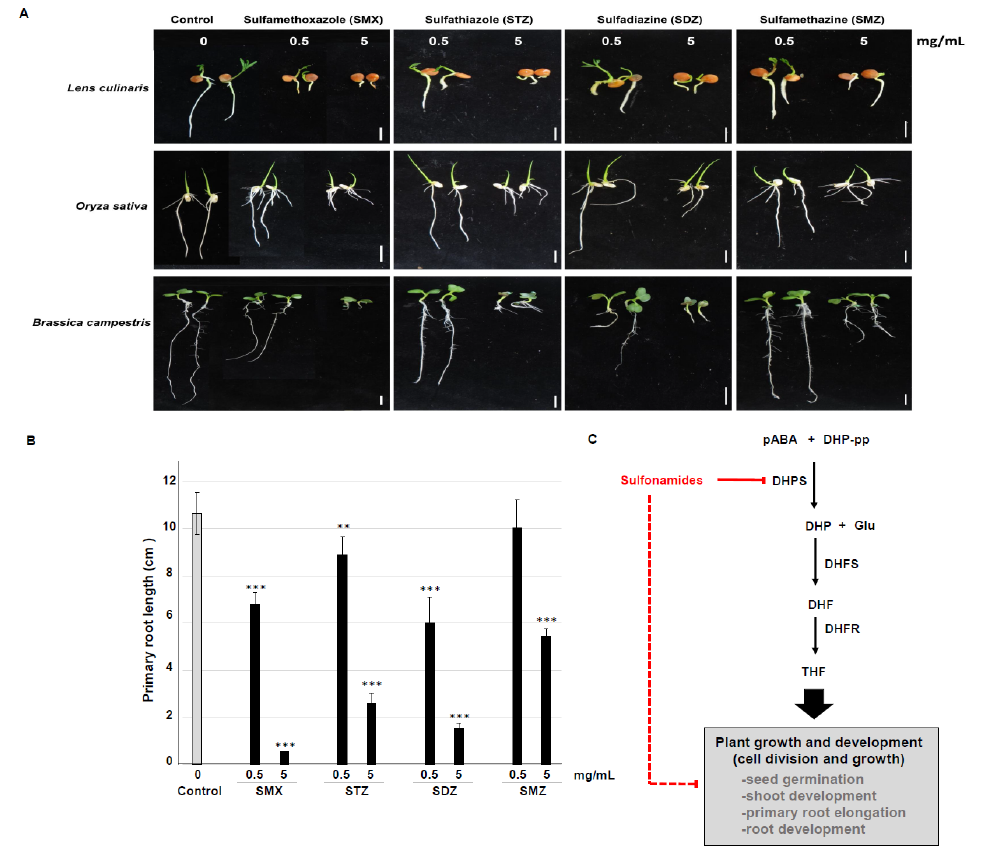
Figure 5. Seedling growth inhibition by sulfonamides and its suggested model. ( A ) Physiological phenotype of seedlings exposed to sulfonamide. Seeds were placed onto 1.2% agar plates containing 0 mg/L, 0.5 mg/L, or 5 mg/L of the indicated sulfonamide and grown vertically in the growth chamber; photos were taken on Day 7. The seeds used were lentils ( Lens culinaris ), rice ( Oryza sativa ), and Napa cabbage ( Brassica campestris ). The four types of embedded sulfonamides were sulfamethoxazole (SMX), sulfathiazole (STZ), sulfadiazine (SDZ), and sulfamethazine (SMZ). White bars = 1 cm. The experiment was repeated three times, with similar results. ( B ) Quantification of primary root length of Napa cabbage (Brassica campestris). Data represent mean ± SE ( n = 27). Asterisks indicate statistically significant differences to the control (0 mg/mL, grey bar) (Student’s t-test; ** p < 0.01, *** p < 0.001). ( C ) A plant growth inhibition model by sulfonamides. Sulfonamides inhibit DHPS in the folate biosynthesis pathway and influence plant growth and development, including seed germination, shoot development, primary root elongation, and root